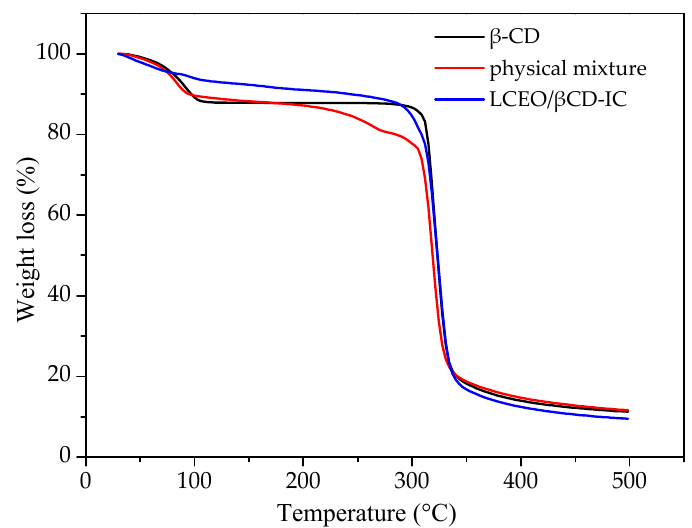
Figure 8. Thermogravimetric curves of β -CD, physical mixture and the LCEO/ β -CD inclusion complex.